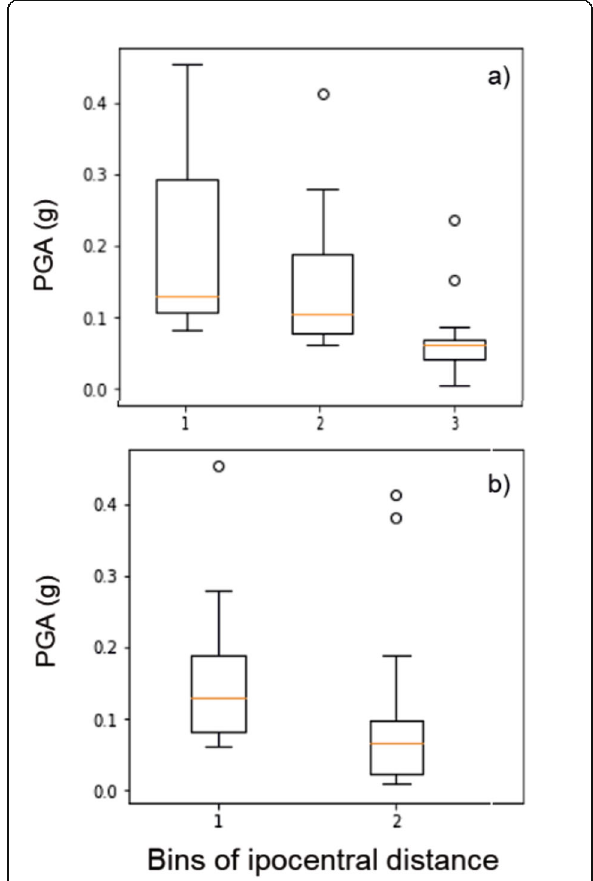
Fig. 7 Box and whistler plots of the two datasets of PGA values recorded at NFAs in the Central Italy Apennine Sector from 1997 to 2017 divided into two ranges of M w : a 5 ≤ M w1 < 5.5; b 5.5 ≤ M w1 ≤ 6.5. The bins of hypocentral distance are: a) 1(0 – 9.95 km), 2(10 – 19.95 km), 3(20 – 29.95 km); b) 1(10 – 19.95 km), 2(20 – 29.95 km). The void circles are the outliers identified by the box and whistler